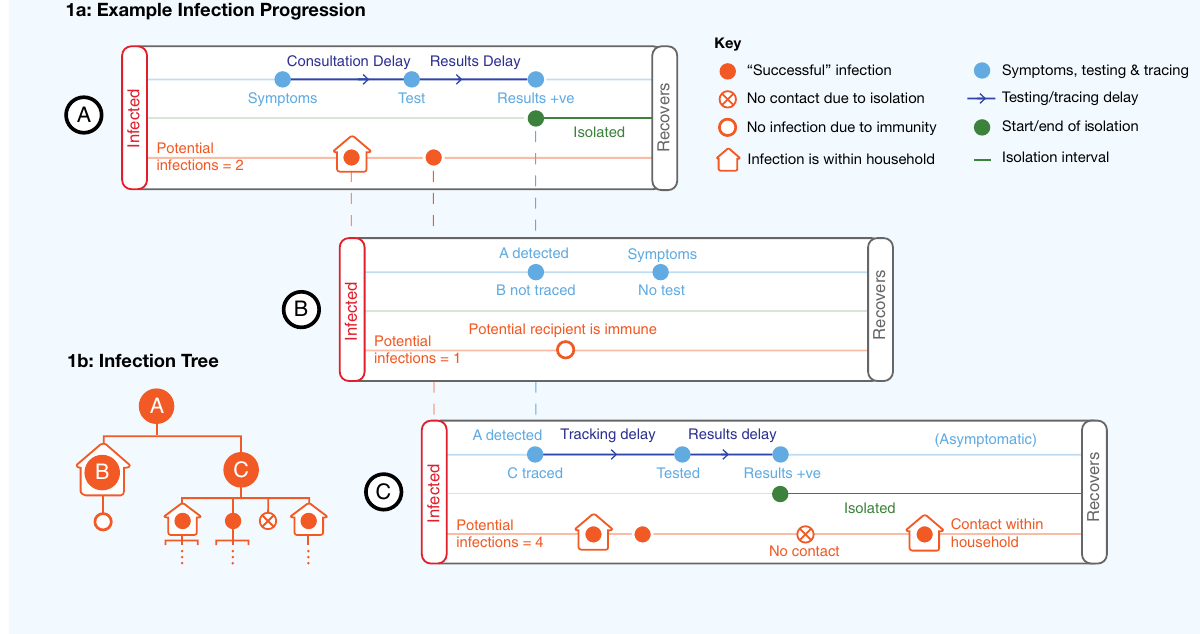
Figure 1. Visual representation of the theoretical model. An initial infection A potentially infects two other individuals, called B and C. ( a ) A successfully infects B and C. A gets tested upon experiencing symptoms, and isolates upon receiving a positive test result. This begins a process of contact tracing, through which C (but not B) is tested. B does not infect anyone else; the only person they potentially infect is immune. C infects two other people before being isolated. Once C is isolated, she does not come into contact with a potential infection outside the household, but still infects an individual in the same household. Individuals in the model may or may not be symptomatic, get tested, be contact traced, and they may isolate for a variety of reasons. ( b ) The infection tree summarises the “branching process” in the model, i.e. the first and second generation potential infections caused by